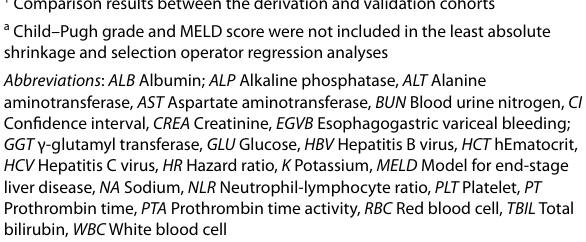
Table 1 Factors associated with prediction of EGVB Table 1 (continued) † Comparison results between the derivation and validation